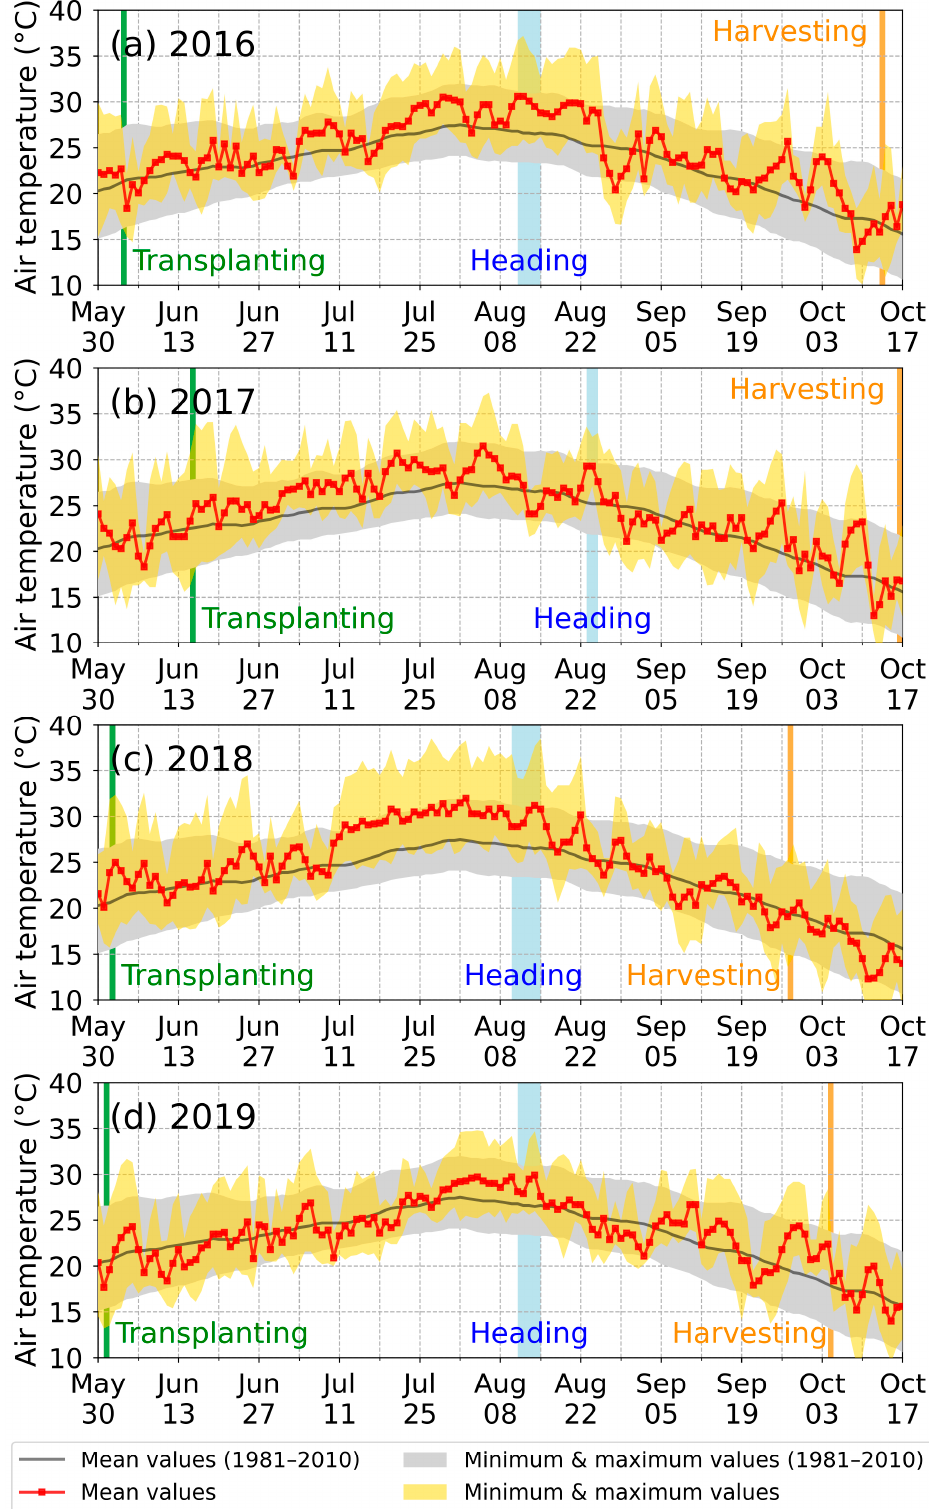
Figure 3. Time series of air temperature for three years in Gwanju, Republic of Korea. Red square plots indicate air temperature and orange shaded lines indicate the minimum and maximum air temperatures. Grey plots and shaded lines represent the mean, minimum, and maximum air temperatures for climatic data (1981–2010 years). ( a ) 2016, ( b ) 2017, ( c ) 2018, and ( d ) 2019.